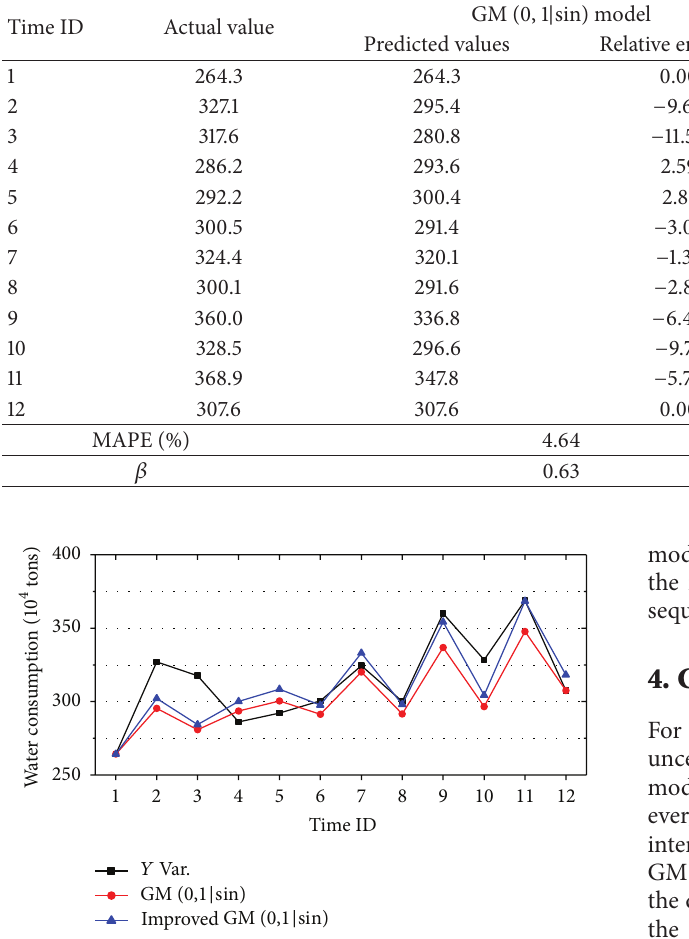
Figure 3: The fitting trend using the two